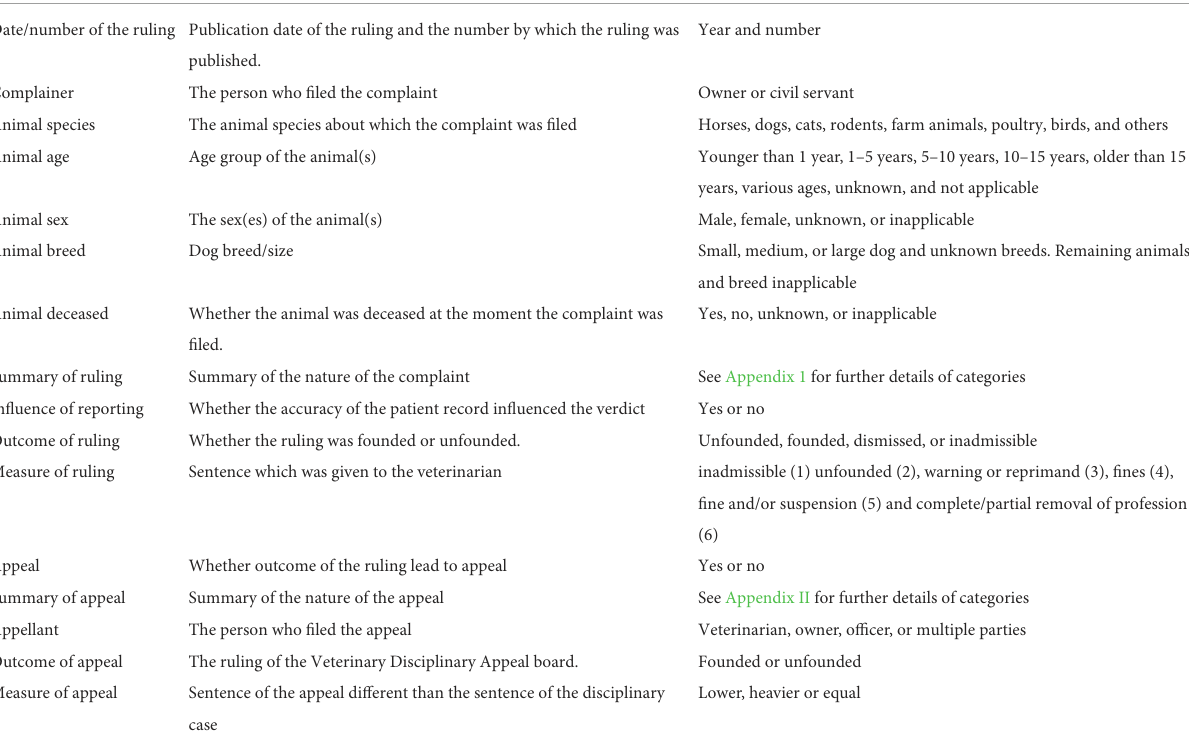
TABLE 1 Value labels and coding used in the dataset veterinary disciplinary council (VDC) and veterinary disciplinary appeal council (VAC). The exact coding can be found in Appendices I and II. Value label Description of value